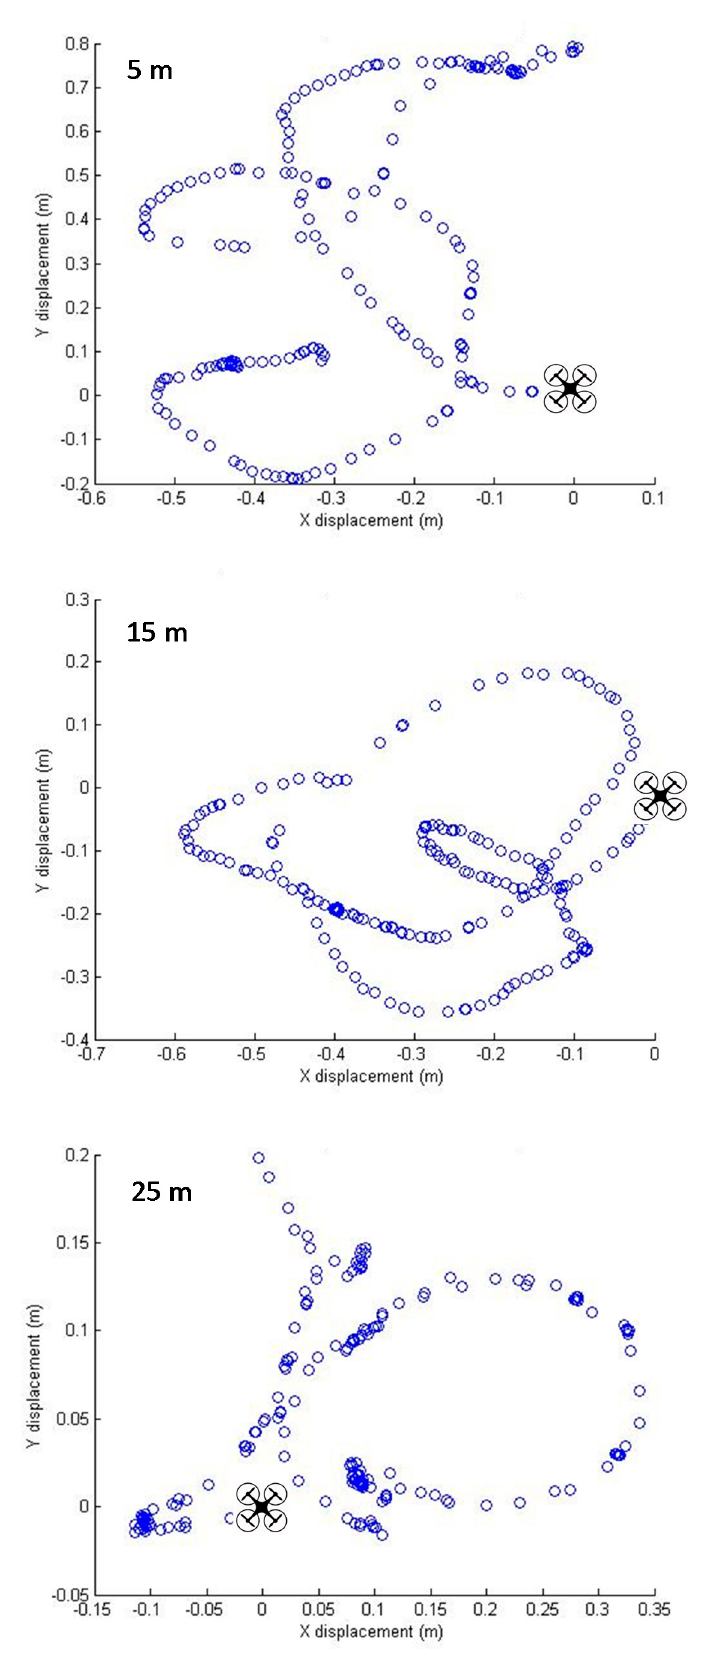
Figure 10. DJI Phantom 2 deviation during the hovering test using image processing.